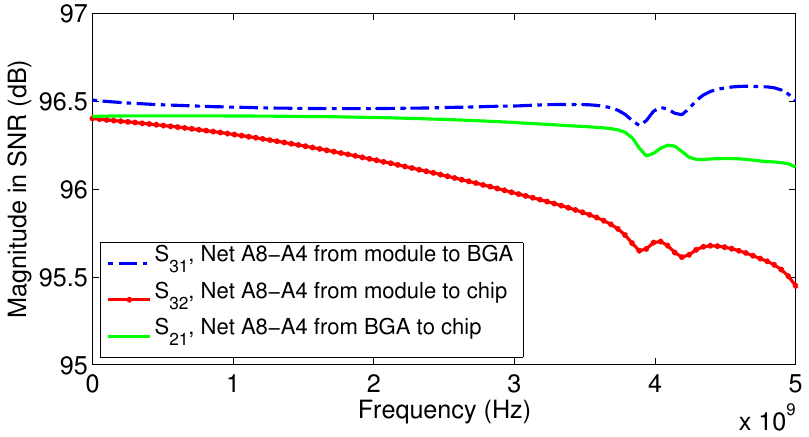
Figure 18. Magnitudes of elements S (SNR) format in the DDR4 module with a DRAM package example with 10 − 5 data accuracy.